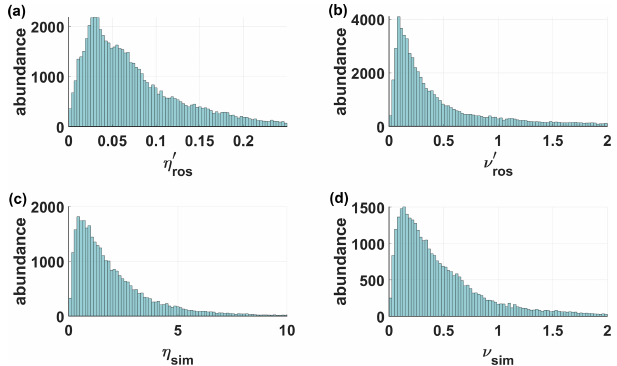
Figure 15. Distribution of viscosities and resistivities ( ν sim , η sim ) computed with Eqs. (22) and (25), compared to reference values ( ν (cid:48) ros , η (cid:48) ros ) computed with Eqs. (31) and